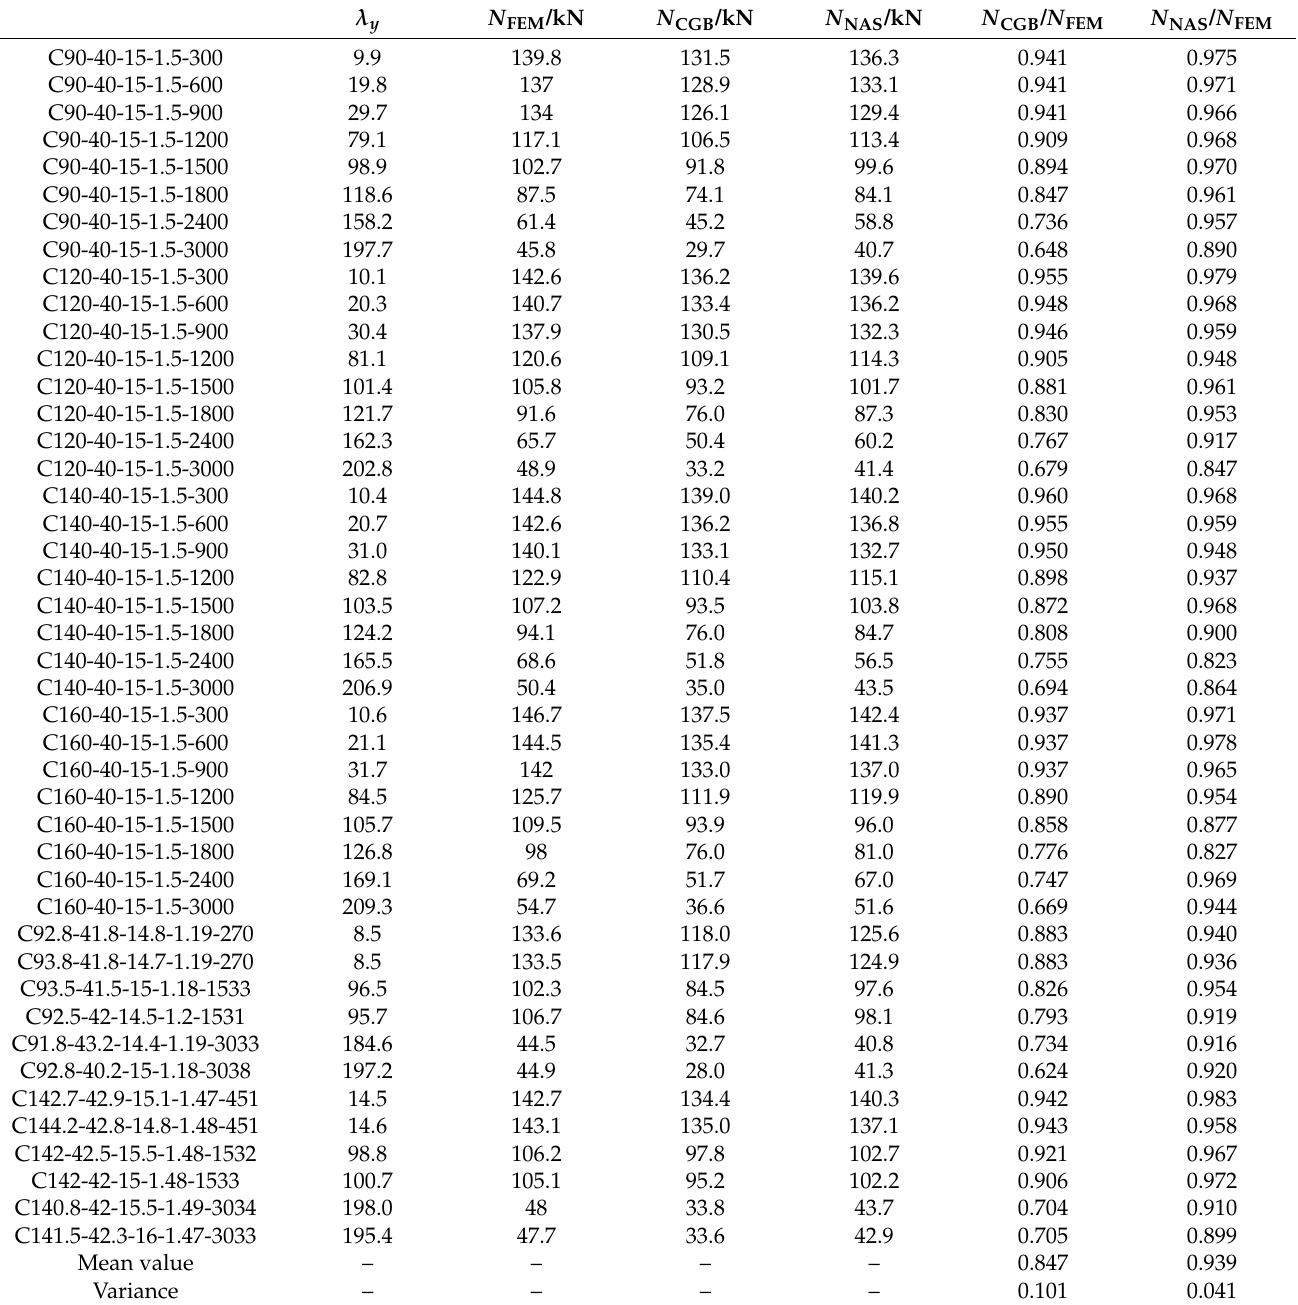
Table A1. Comparisons of the bearing capacities between numerical analyses and